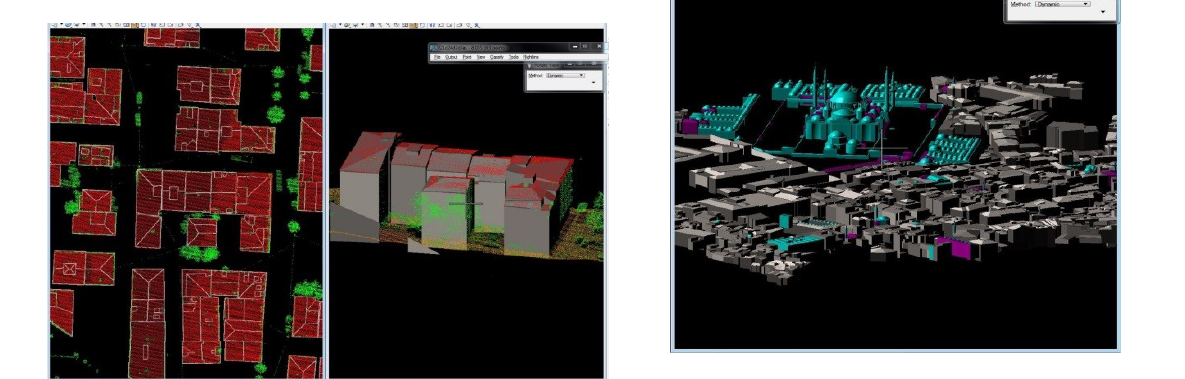
Figure 7: Solid buildings model